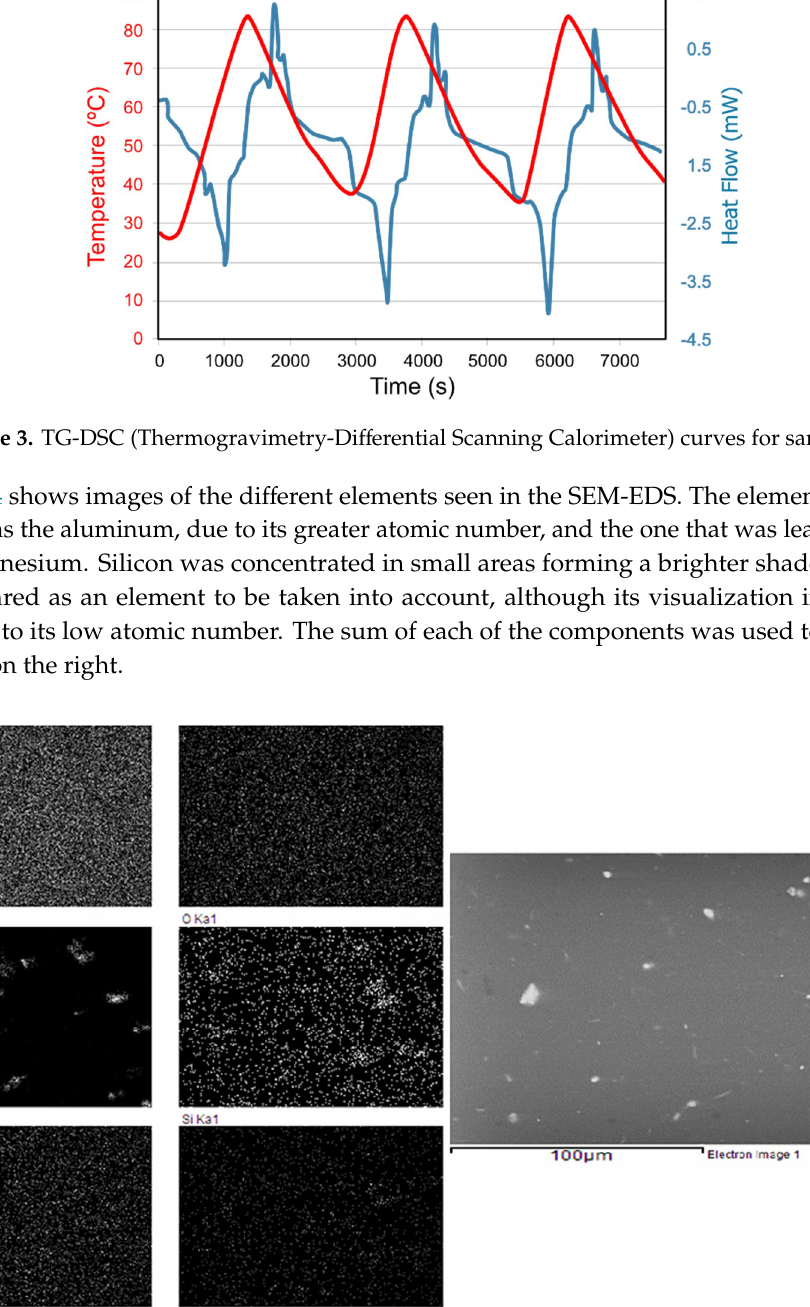
Figure 5. Atomic spectrum and quantification by scanning electron microscope and energy dispersive spectroscopy (SEM-EDS) equipment.